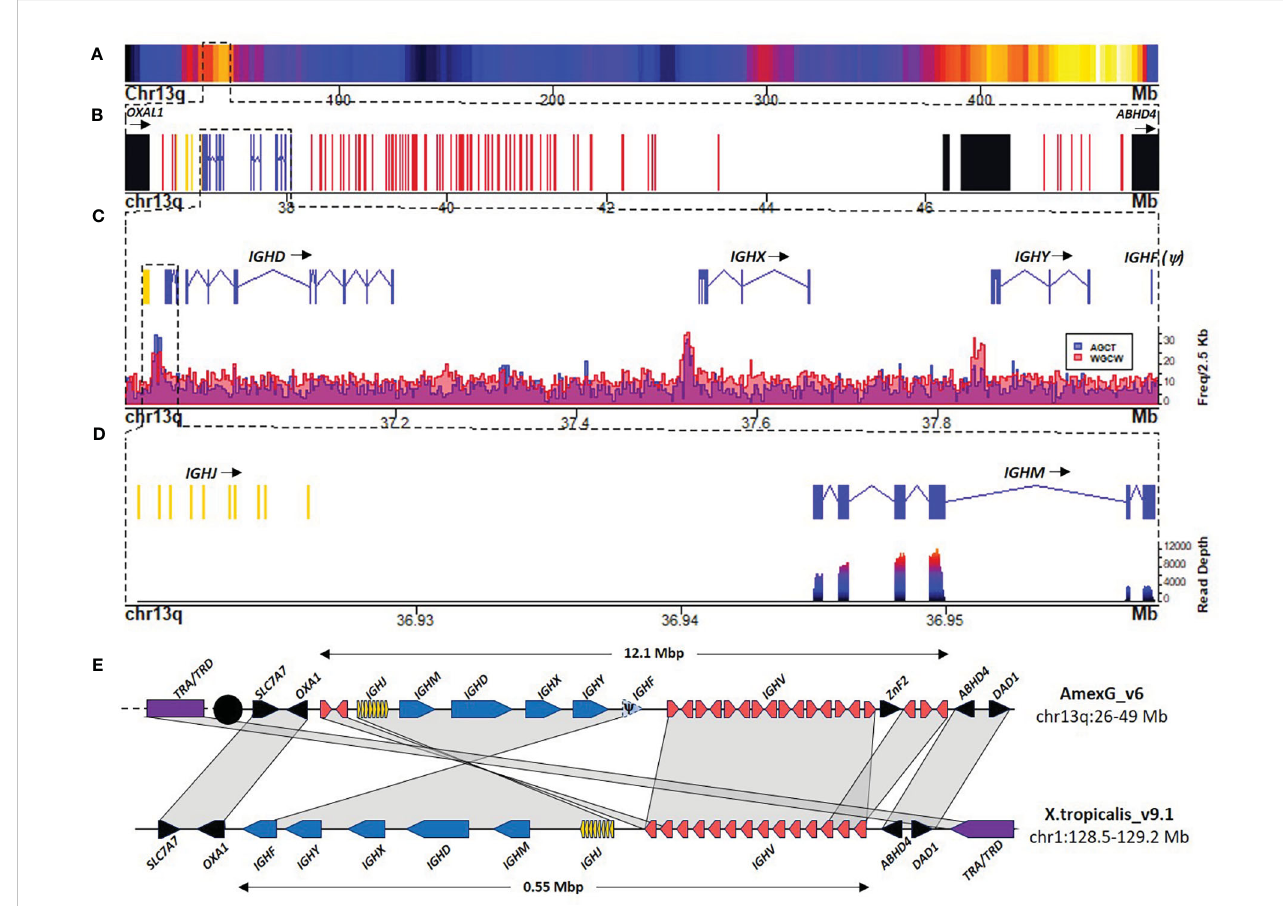
FIGURE 1 The heavy chain locus is located in the centromeric portion of chr13q (483 Mbp). (A) Gene density plot of chr13q where the IGH locus is encoded (box). Dark blue colors indicate low gene density. (B) Zoom of the whole IGH locus (35.967 – 48.91 Mbp). Non-Ig genes (black) in proximal fl ank OXA1L gene and distal fl ank ABHD4 , IGHC genes (blue), IGHV genes (red), and IGHD and IGHJ (yellow). (C) Zoomed view (36.9 – 38.09 Mbp) of the IGHJ-IGHC gene cluster. The lower panel shows AID hotspots density per 2.5 Kb along the IGHJ-IGHC cluster to map Switch regions. (D) Close-up of the IGHJ cluster and the IGHM gene. The bottom panel shows the spleen RNA-seq coverage histogram of the IGHJ-IGHM region. (E) Schematic representation of IGH locus in A. mexicanum genome (v6) and the corresponding locus in X. tropicalis . Color code as in A X. tropicalis displays the canonical architecture, in which the V, J and C clusters have the same orientation. Note that in A. mexicanum the JH-CH cluster and 3 IGHV segments appear to be inverted, which seems implausible due to the mechanism of V(D)J recombination. Moreover, IGHV segment orientation in axolotl are intercalated, which is atypical. Interestingly, in axolotl, the TRA/TRD locus (Yellow) is not linked to the IGH locus as in X. tropicalis and is coded across the centromere (black circle) in chr13p: 3.3-7.7 Mbp). Not on scale. The IGHD cluster is not shown for